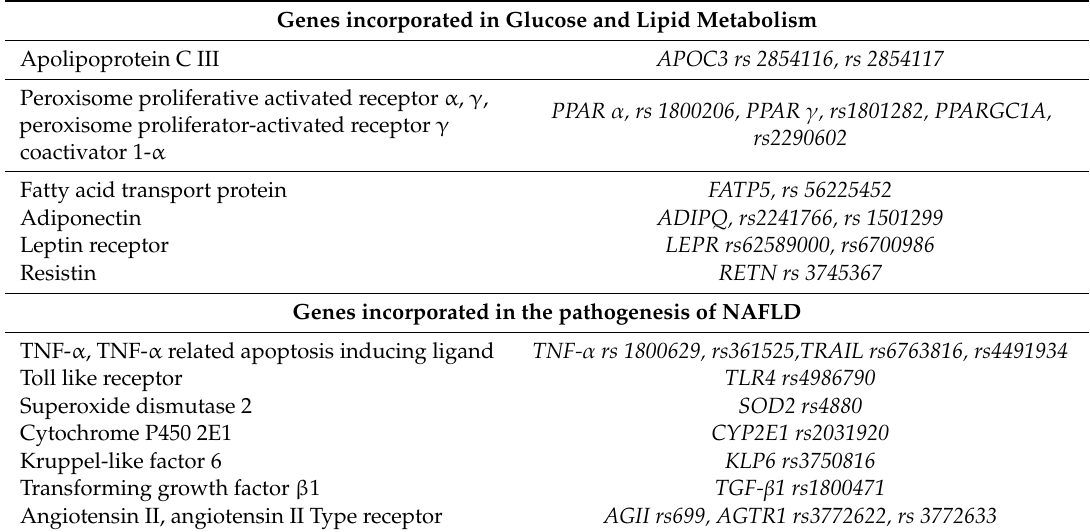
Table 1. Summary of single nucleotide polymorphisms (SNPs) related to nonalcoholic fatty liver disease